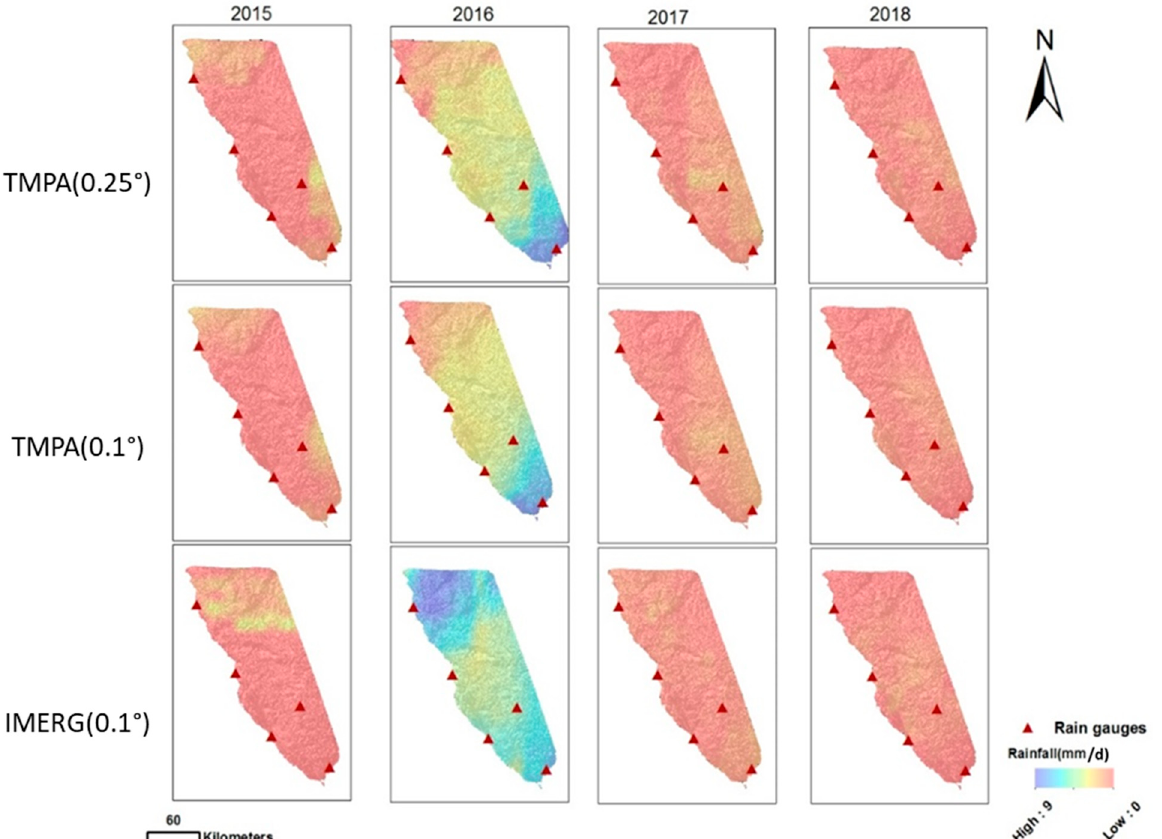
Figure 2. Spatial distribution of rainfall over the area for each of the four events studied using TMPA and IMERG accumulated scenes